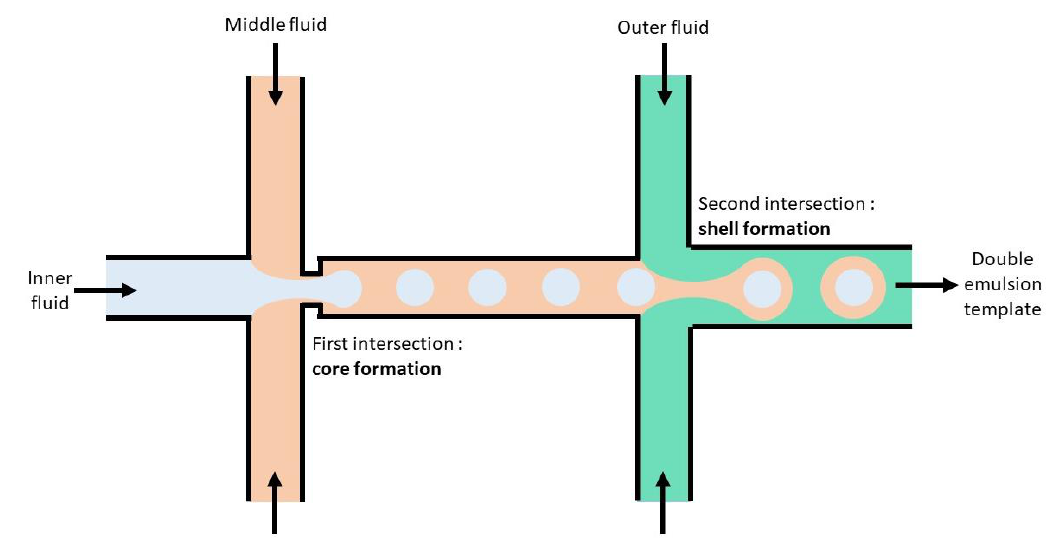
Figure 4. Double emulsion template formation by successive intersections in microfluidic chip.